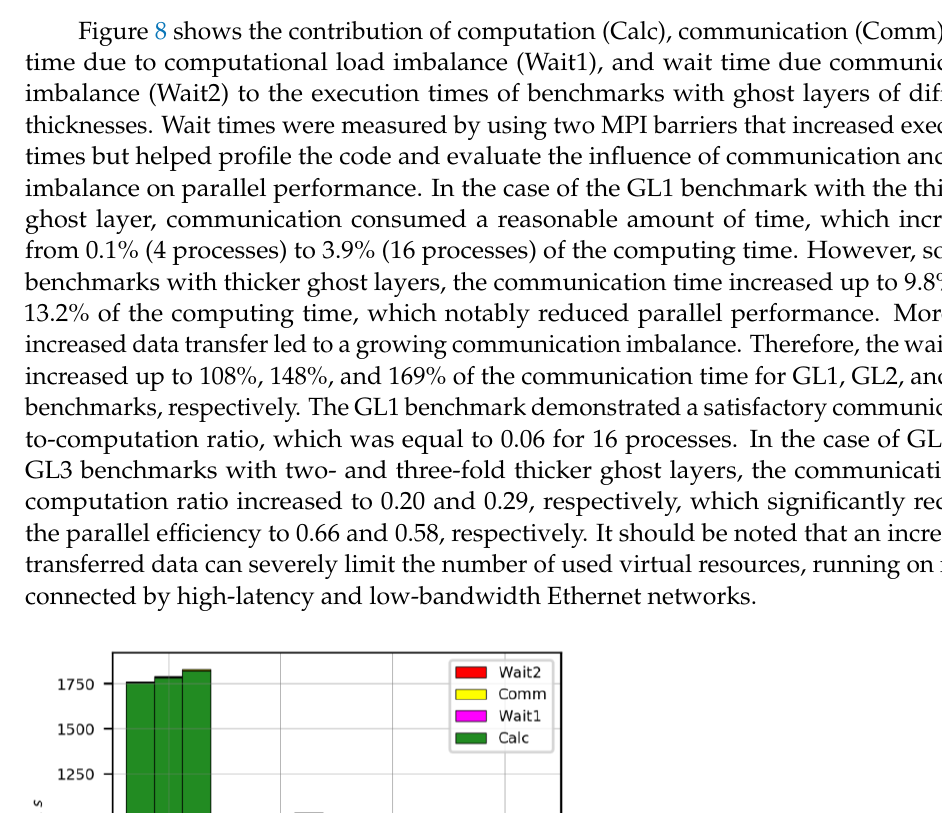
Figure 7. Speedup of parallel computations.